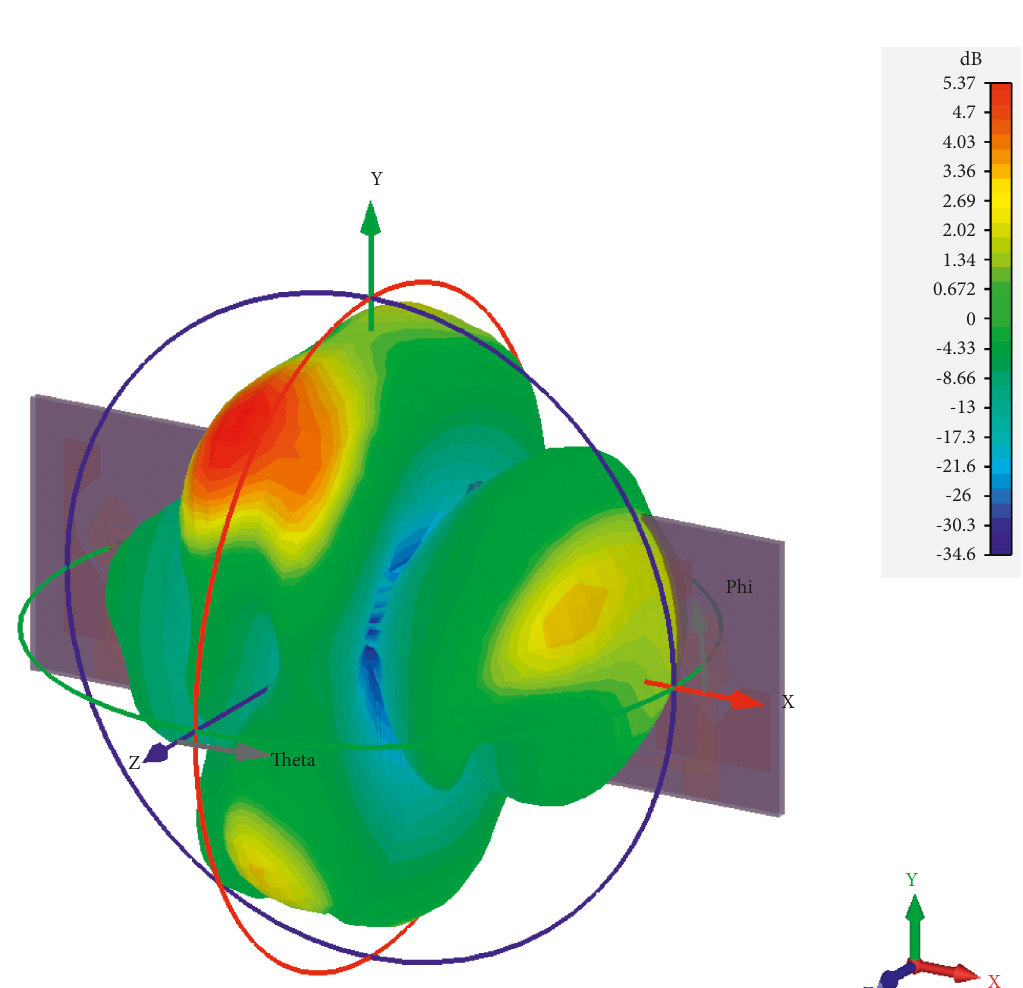
Figure 21: 3D Radiation pattern (1 × 4